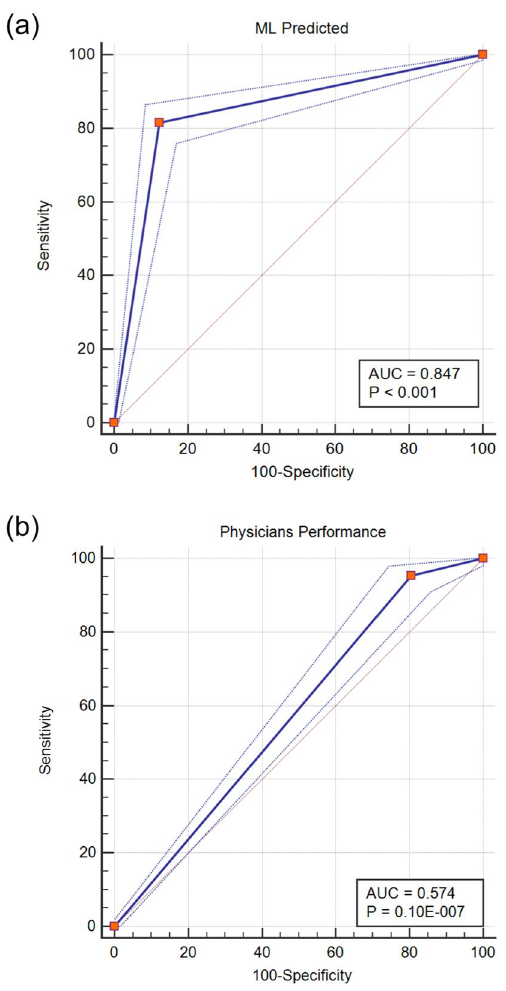
Figure 5. ROC Curves and the Classification AUCs Based on Machine Learning and Physician Diagnoses. ( a ) Classification using machine learning and ( b ) classification based on physician